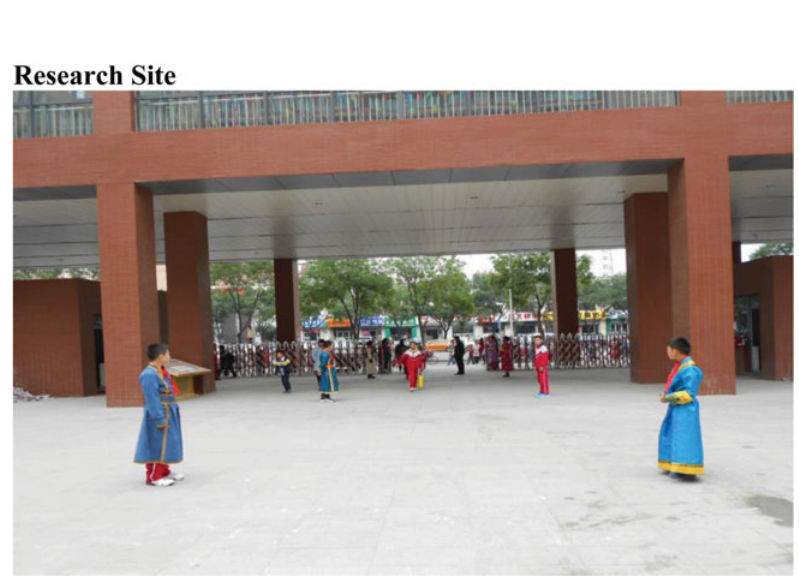
FIGURE 2 (Colour online) Entrance to research site: Bilingual school in